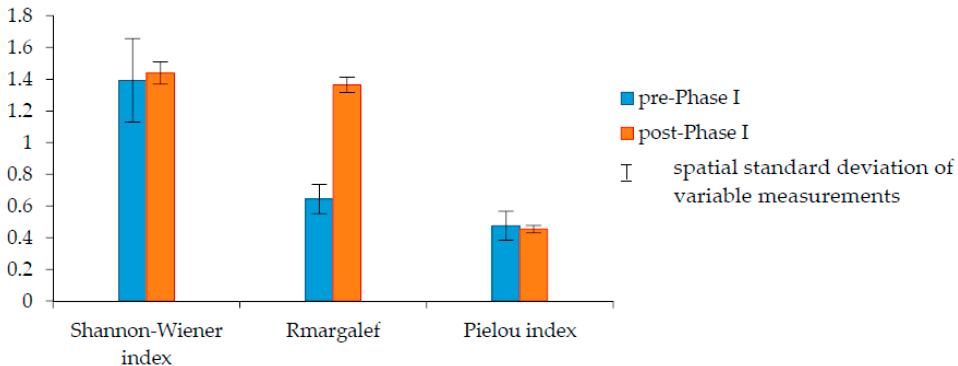
Figure 6. Comparison of phytoplankton biodiversity between pre- and post-Phase I project.